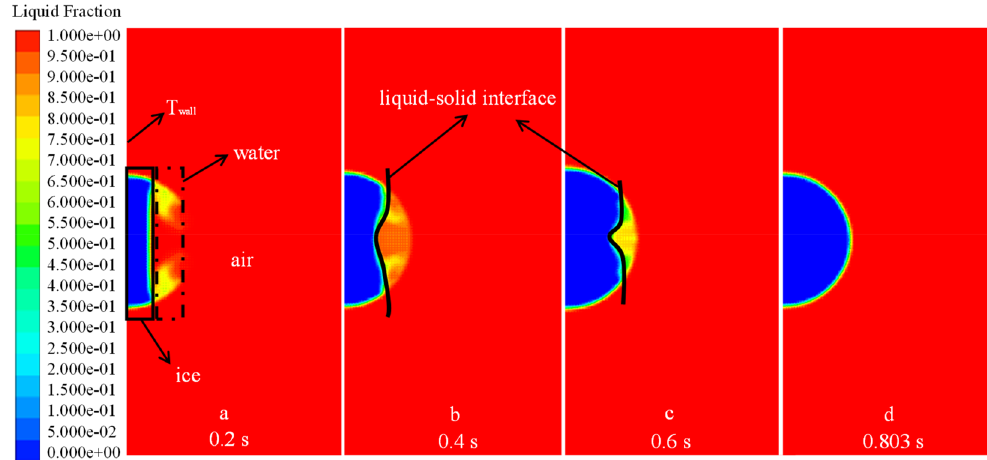
Figure 6. r = 1 mm liquid–solid phase volume fraction.